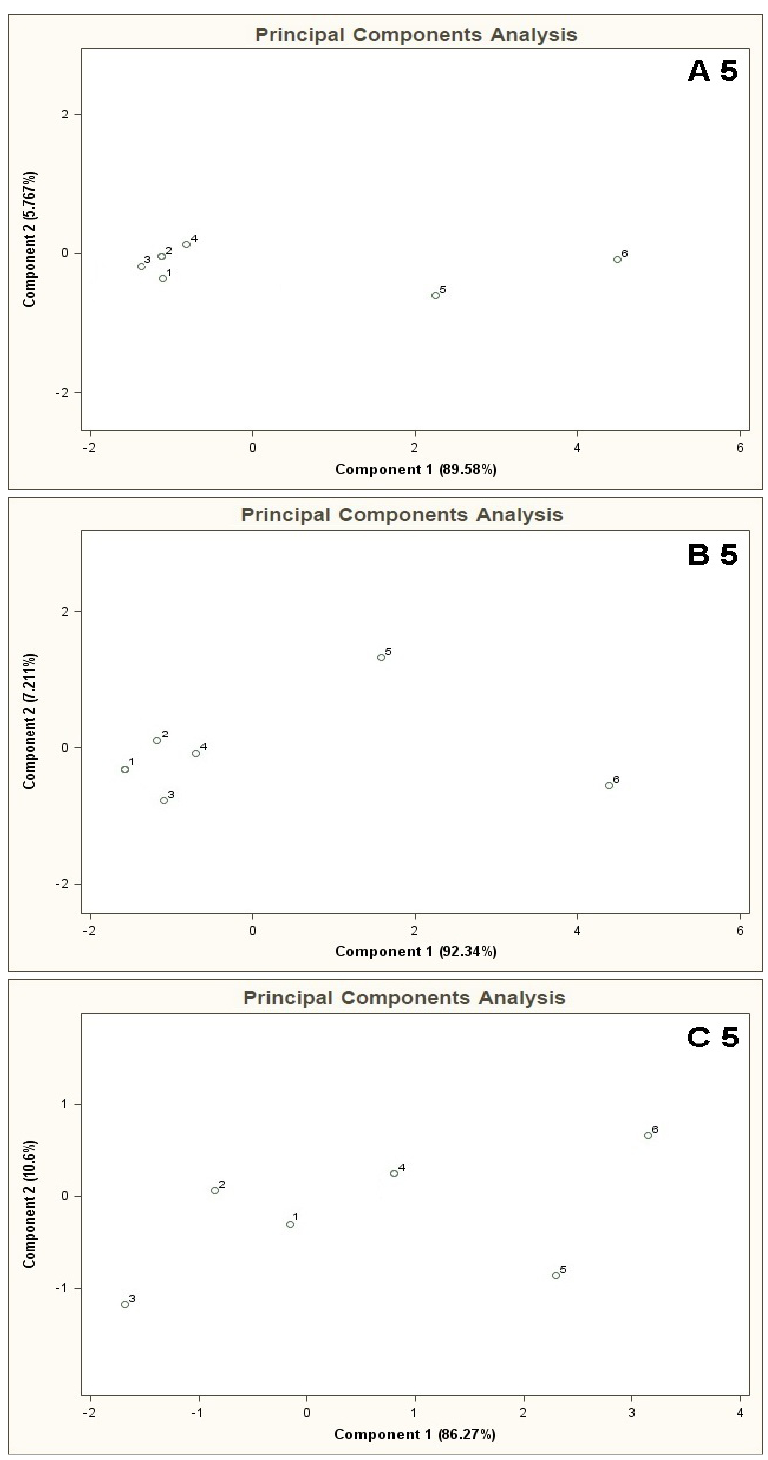
Figure 4. Result of PCA for the mixtures of type A 5 , B 5 , C 5 , where A 5, B 5, C 5 are the aqueous solutions of the basic components (acetone, isoprene, carbon disulphide, propan-2-ol, formamide) having the concentration of each component in the mixture equal 10 ppb, 25 ppb and 50 ppb v/v, respectively. 1–6 are the mixtures of reference substances with the COPD markers of the respective concentrations: 0 ppb, 5 ppb, 10 ppb, 25 ppb, 50 ppb, 100 ppb v/v. Measurement was obtained for time instant 60